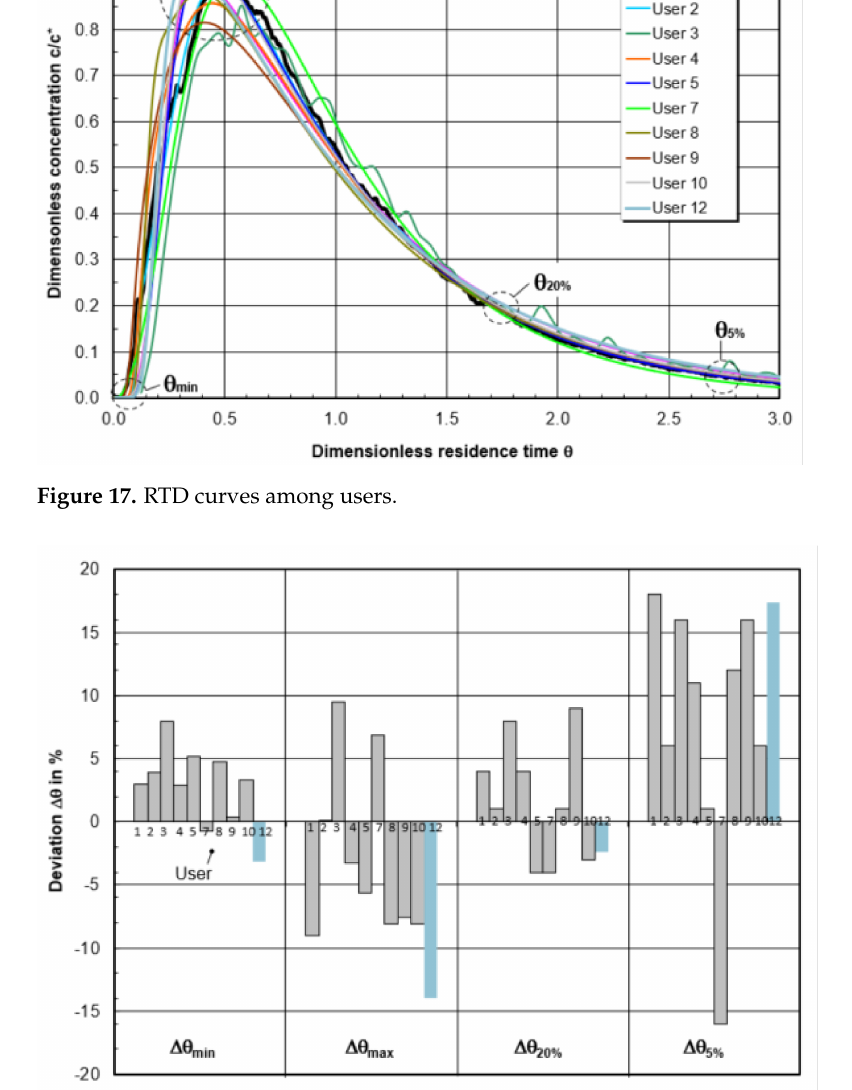
Figure 18. Relative deviation of the calculated RTD data ∆ θ min , ∆ θ max , ∆ θ 20% , ∆ θ 5%